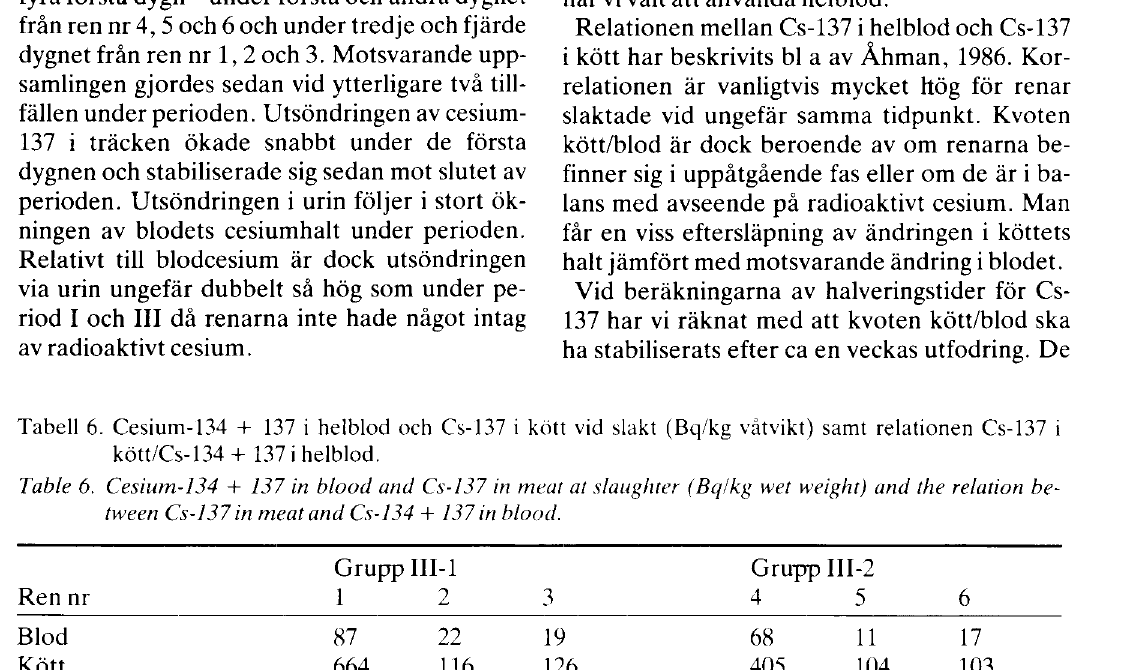
Table 6. Cesium-134 + 137 in blood and Cs-137 in meat at slaughter (Bq/kg wet weight) and the relation be tween Cs-137 in meat and Cs-134 + 137 in blood.